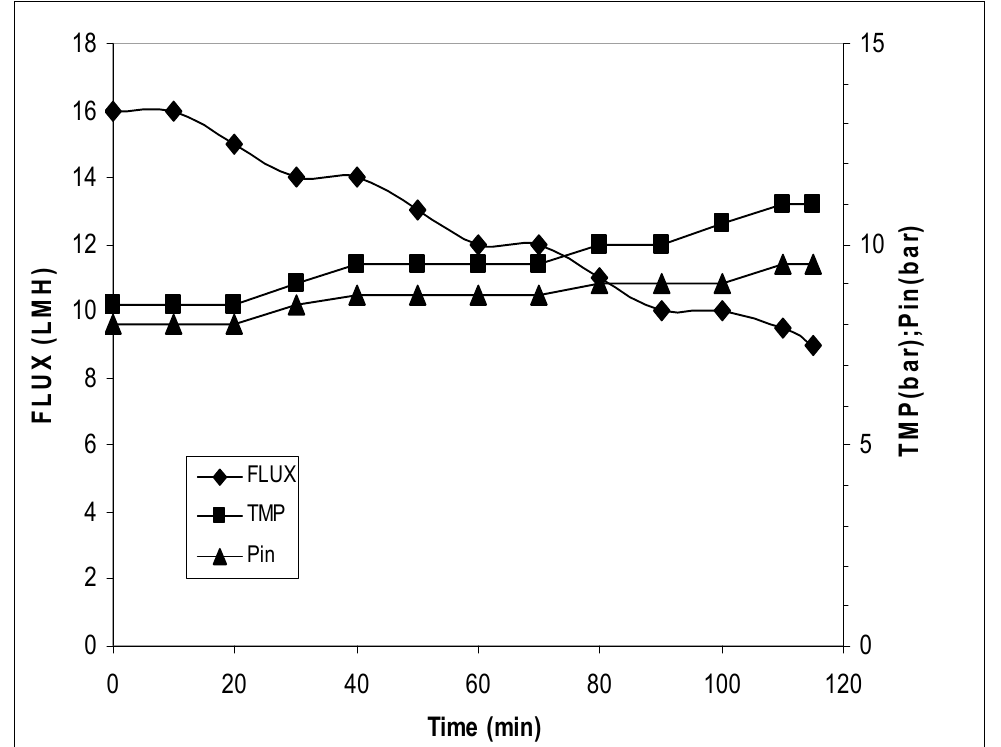
Figure 4. Transmembrane flux, corresponding TMP, and inlet pressure during nano filtration treatment. The experiments were performed in triplicate.